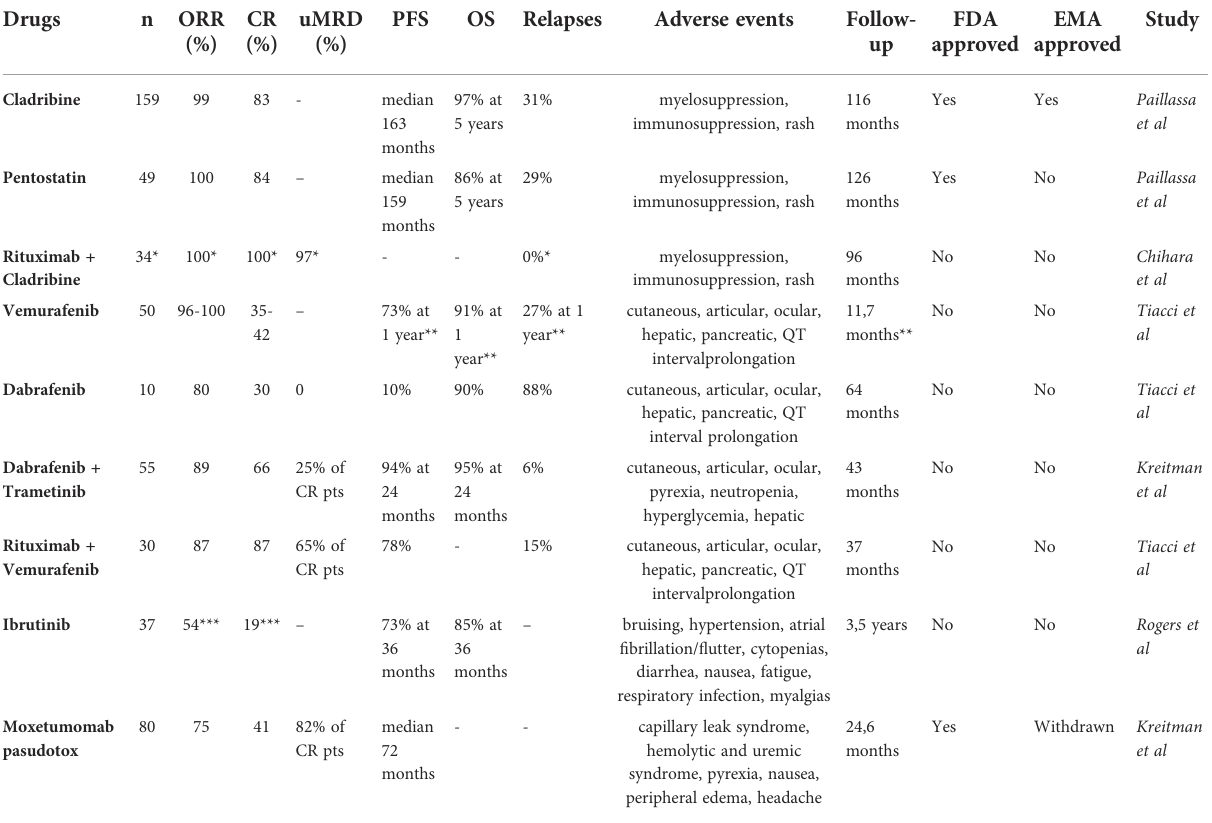
TABLE 2 Drugs currently used in hairy cell leukemia (HCL) and HCL-like disorders.